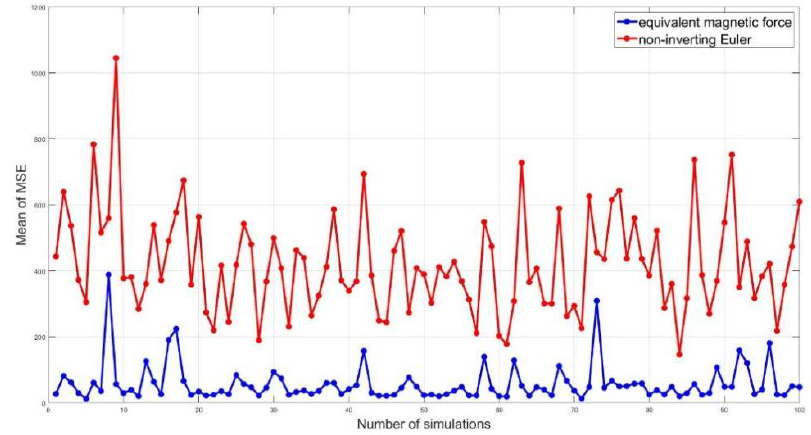
Figure 5. Robustness comparison diagram of the non − inverting Euler method and equivalent mag- netic force method.